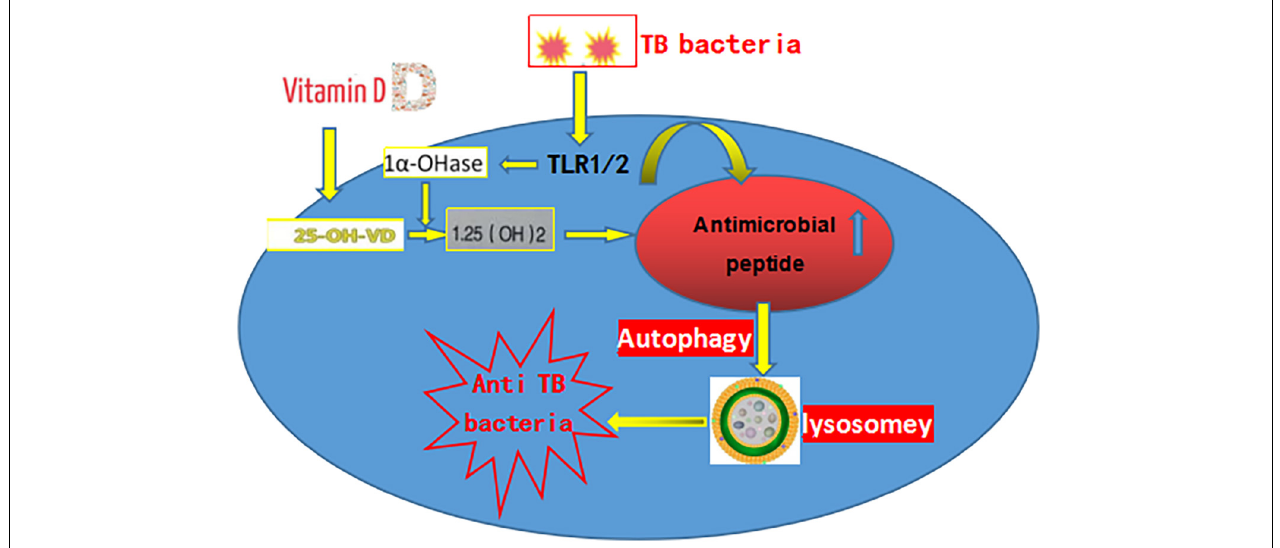
FIGURE 1 | The pathogenesis of